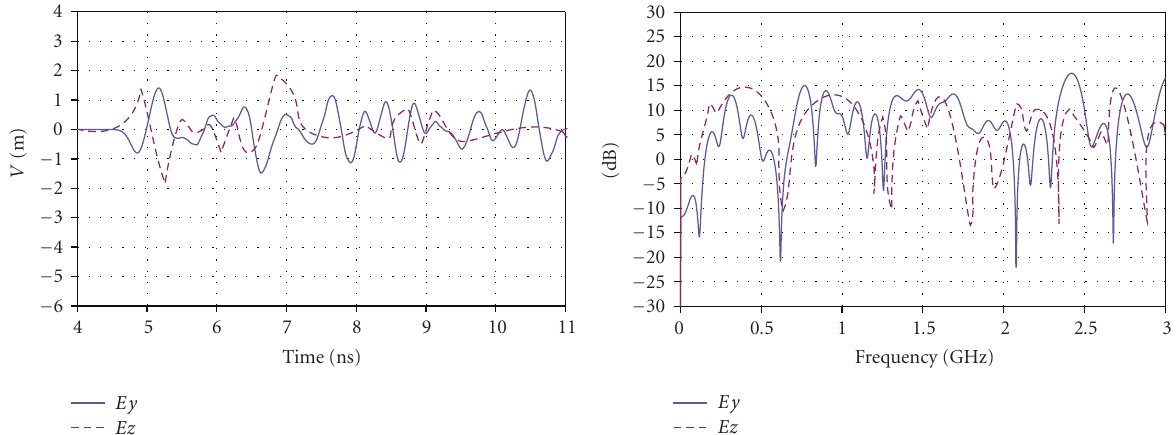
Figure 13: Radiated fields along the x -axis with corrugations.